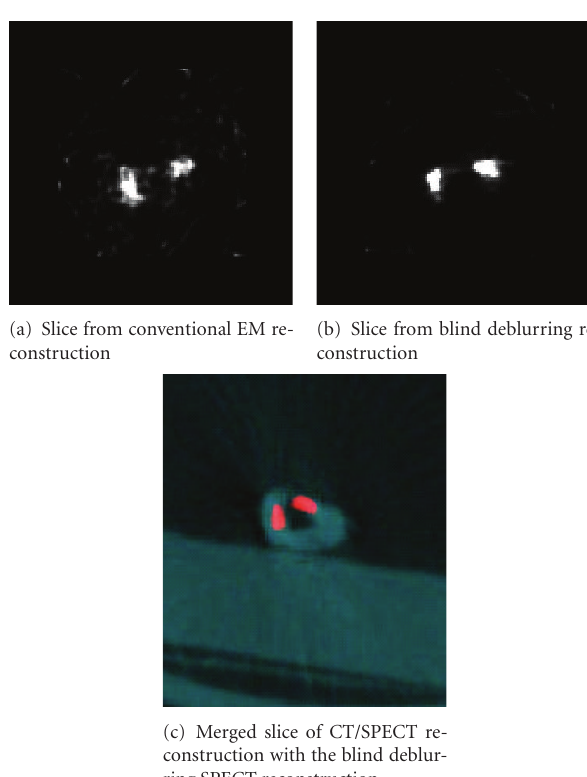
Figure 7: One slice of a mouse-heart reconstruction.